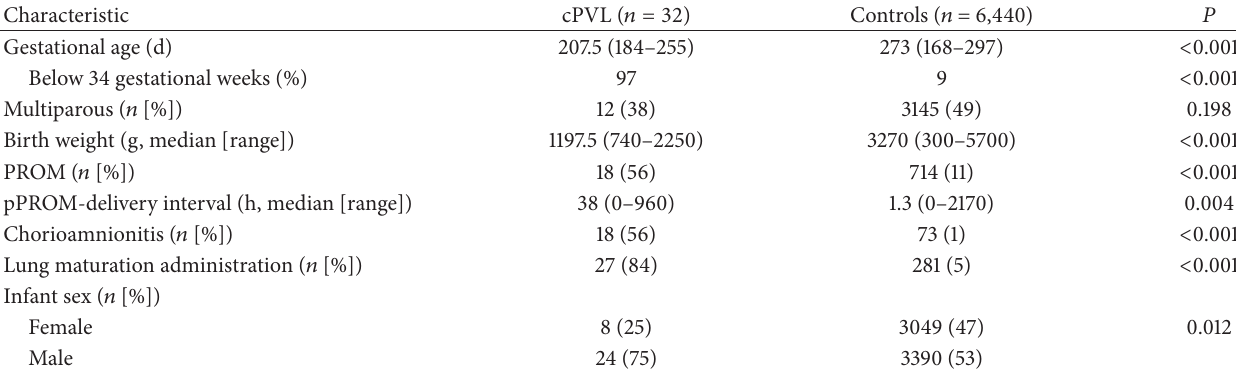
Table 1: Baseline cystic periventricular leukomalacia (cPVL) and control group characteristics.